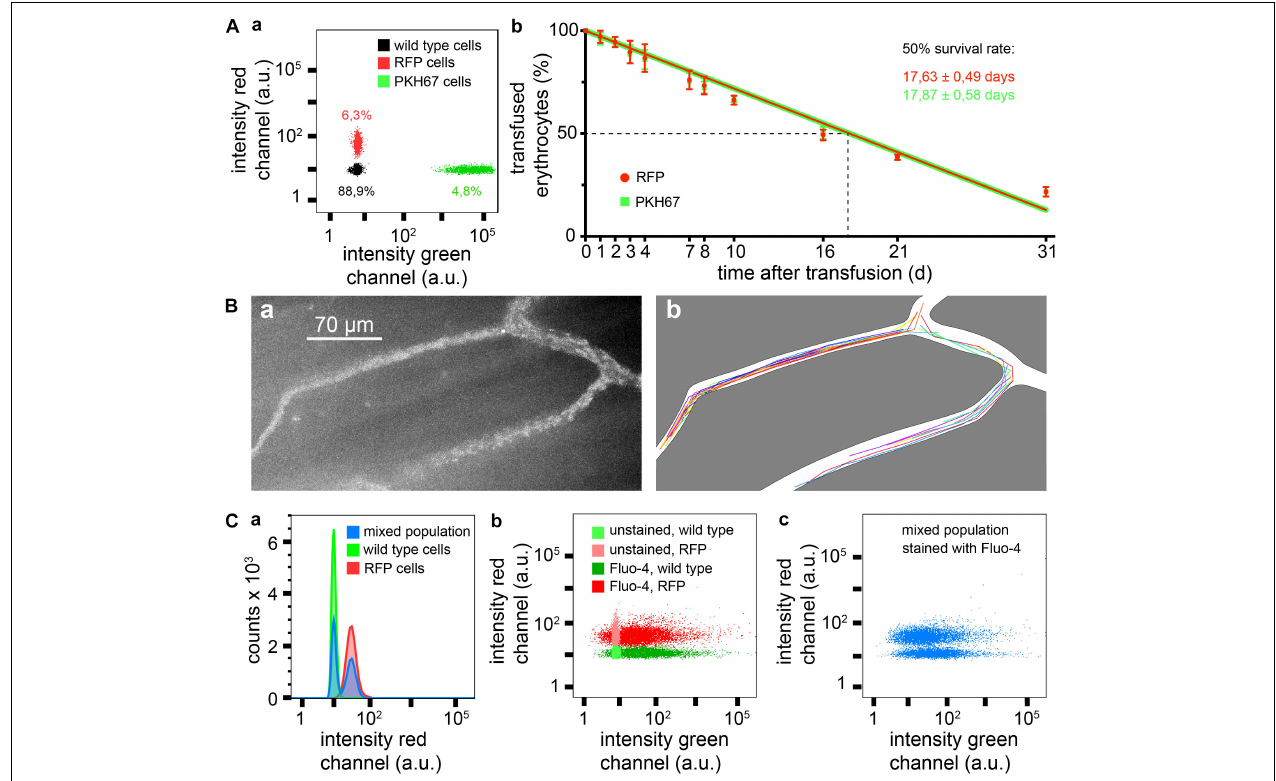
FIGURE 2 | Measurements based on RFP erythrocytes. (A) Survival of transfused erythrocytes, (Aa) flow cytometric sample measurement immediately after transfusion showing 6.3% of RFP cells and 4.8% of PKH67 stained cells, and (Ab) statistical analysis of four transfusions over a time period of 1 month, RFP and PKH67 stained erythrocytes were simultaneously transfused in the same mouse to face identical conditions. (B) Intravital imaging of transfused RBCs, (Ba) maximal intensity projection of a time series of images, and (Bb) trajectories of individual erythrocytes from the same image stack as shown in Ba. (C) Flow cytometry of Fluo-4 loaded erythrocytes from RFP + / + and RFP − / − mice, (Ca) histograms of red fluorescence of RFP − / − and RFP + / + erythrocytes and of a mixed population (simulating transfusion), (Cb) dot plot for red vs. green fluorescence of Fluo-4 stained and unstained RFP + / + and RFP − / − erythrocytes, and (Cc) dot plot for red vs. green fluorescence of a Fluo-4 stained mixed population of RFP and wild type erythrocytes (simulating